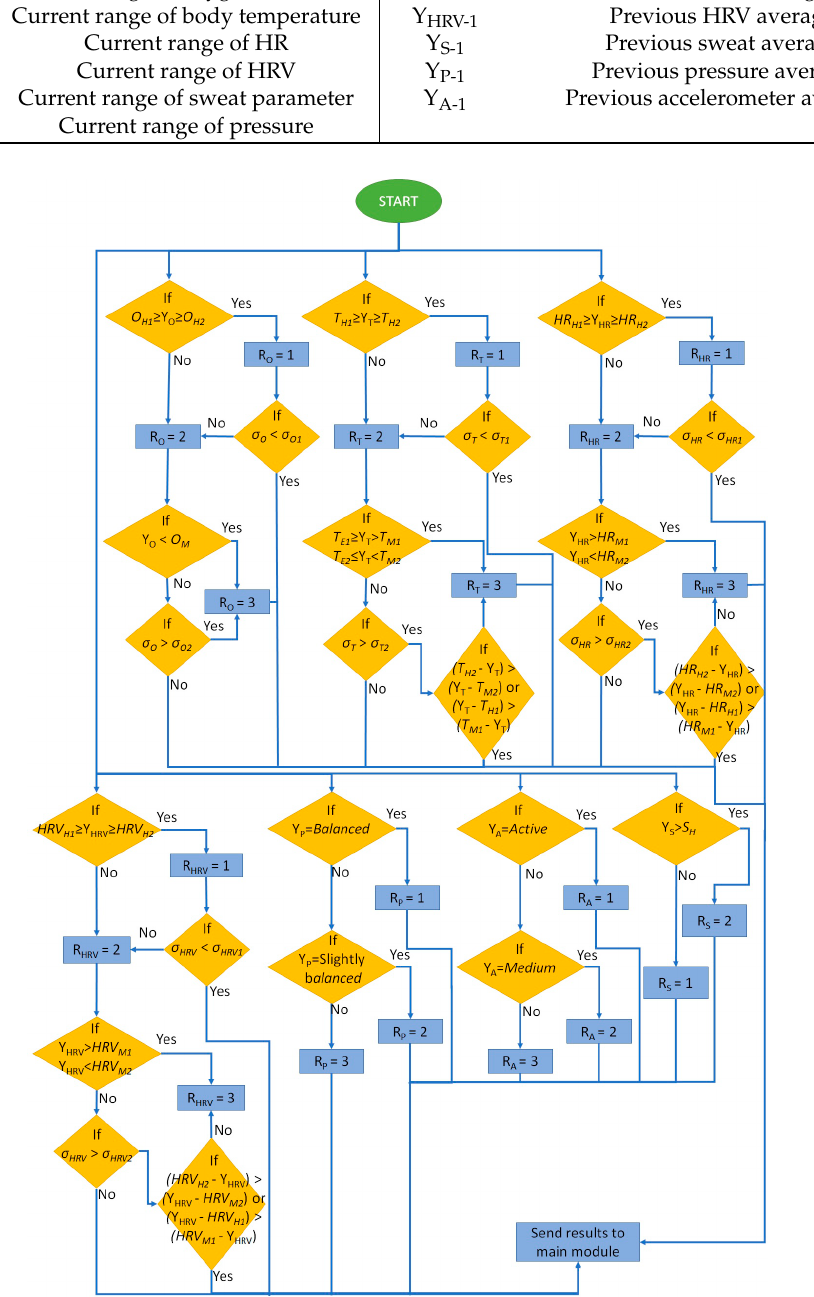
Figure 4. Algorithm for the wellness range evaluation.